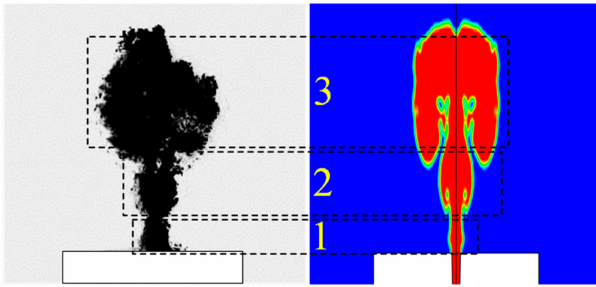
Figure 16. Comparison of numerical and experimental results (100m, expansion ratio of 1.5625).